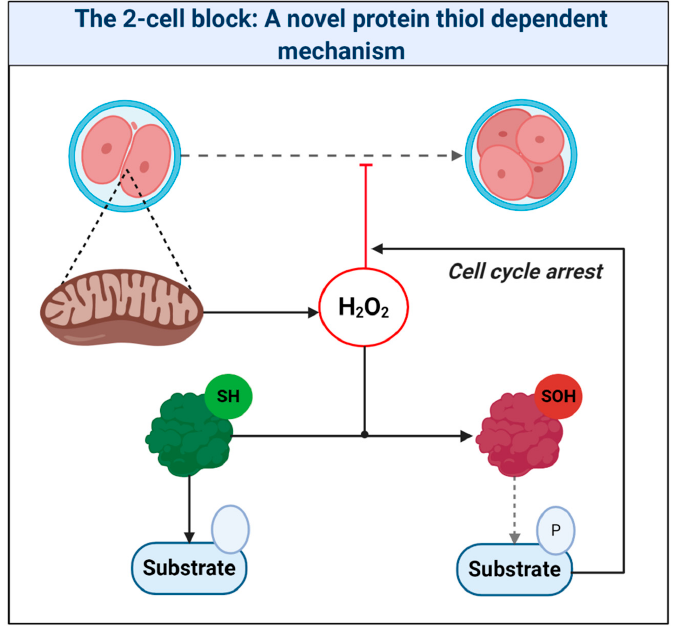
Figure 7. The 2-cell block: A novel protein thiol-dependent mechanism. The scheme depicts mitochondria-derived hydrogen peroxide oxidizing the catalytic (Cys373) thiol of the tyrosine protein phosphatase cdc25c to a sulfenic acid (SOH). Thiol oxidation renders cdc25c unable to dephosphorylate target substrates. The resultant perturbation in zygotic phosphorylation tone could cause cell cycle arrest.